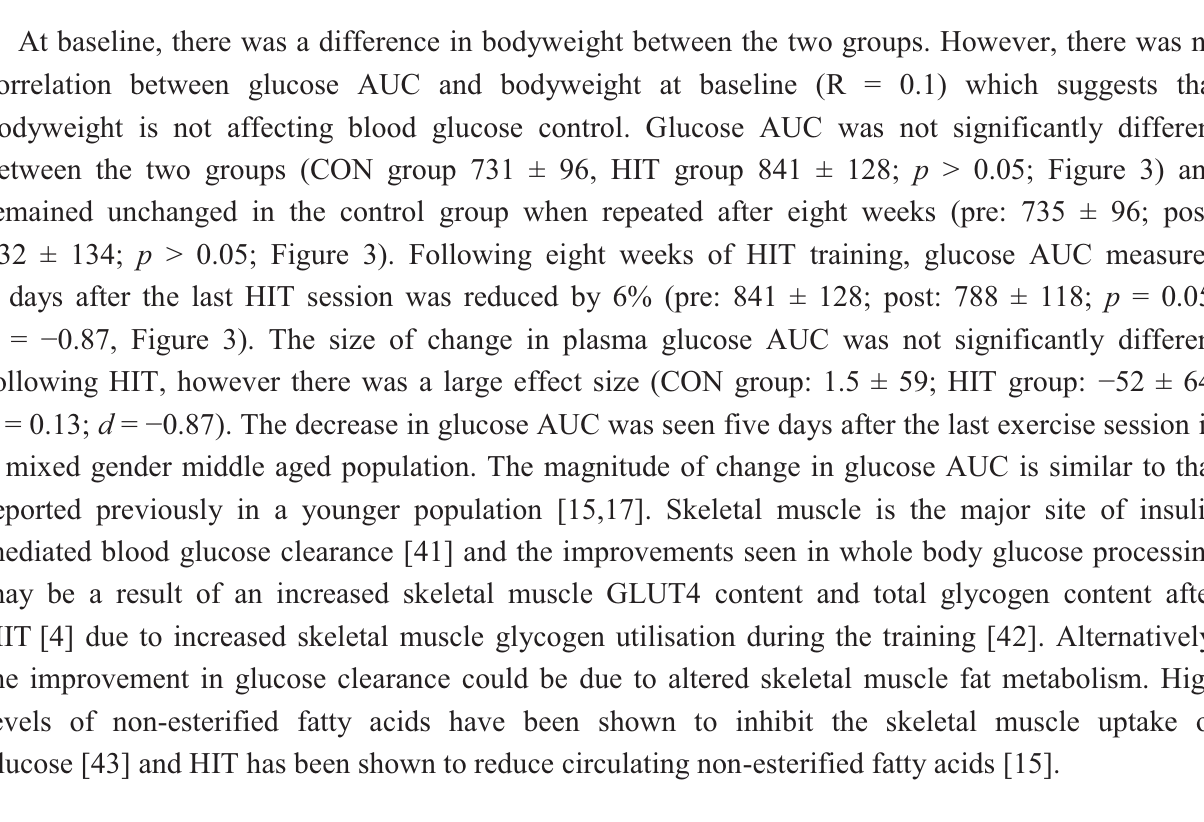
Figure 3. Change in glucose AUC for control and HIT pre and post intervention. * p < 0.05 pre to post within